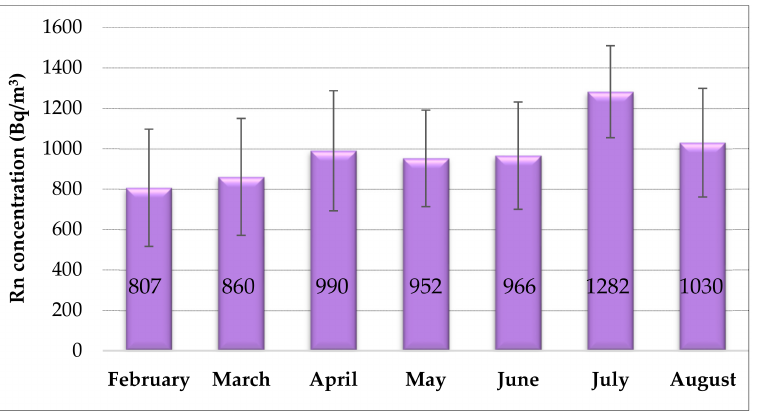
Figure 2. Monthly averaged radon concentrations for the